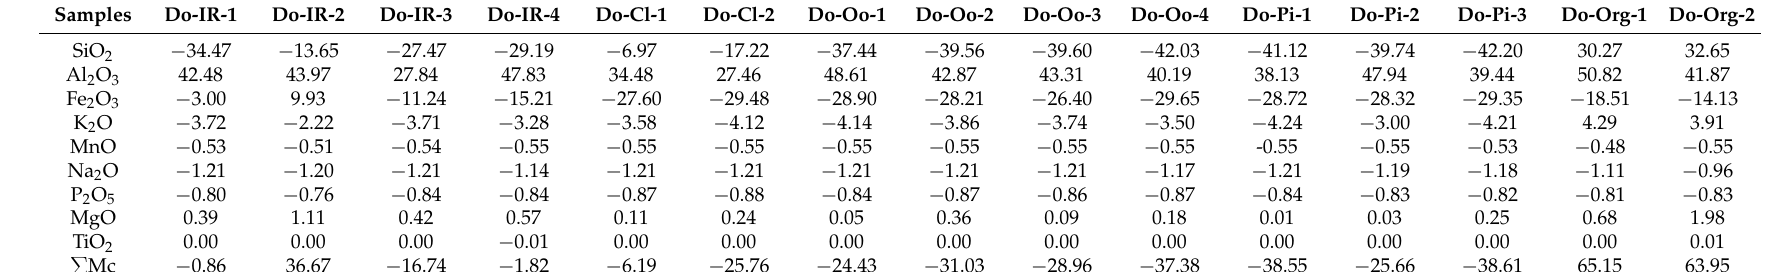
Table 5. Mass changes (in %) of the Dopolan samples based on the reconstructed compositions (RC, in wt %).